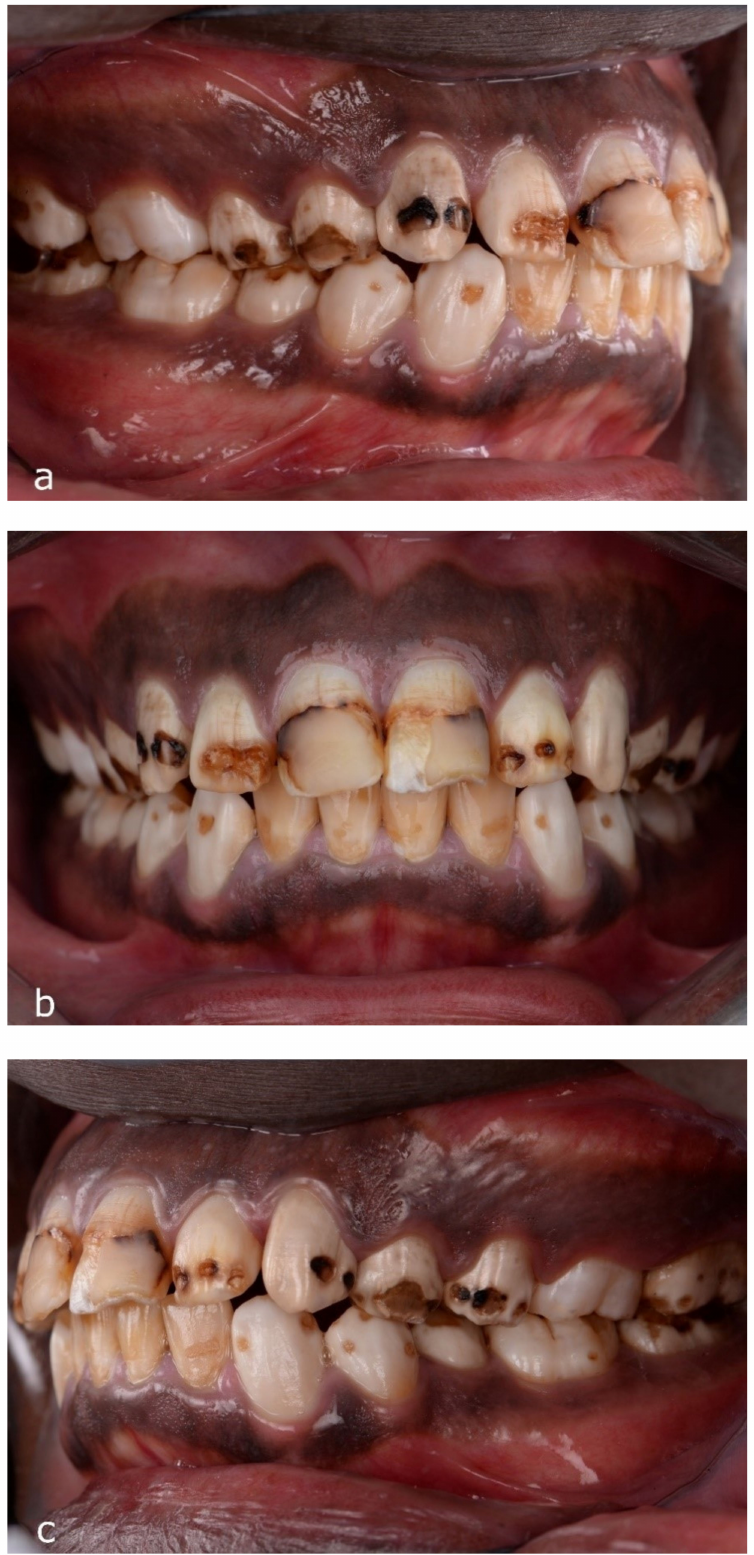
Figure 2. Retracted intraoral views of pretreatment: ( a ) right lateral view, ( b ) frontal view, and ( c ) left lateral